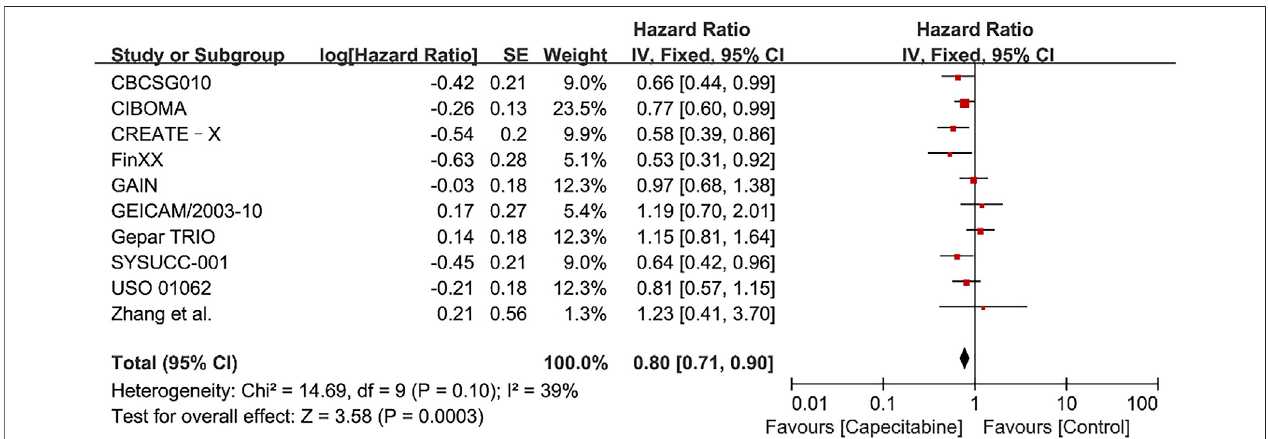
FIGURE 2 | Forest plots for the disease-free survival (DFS) rate in the comparison between chemotherapy with capecitabine group vs. capecitabine-free group in TNBC patients.